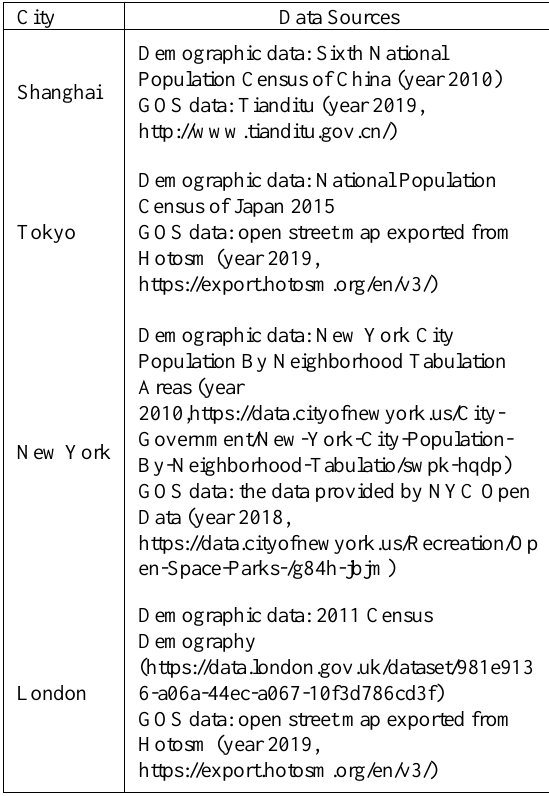
Table 2. Data sources of demographic and GOS